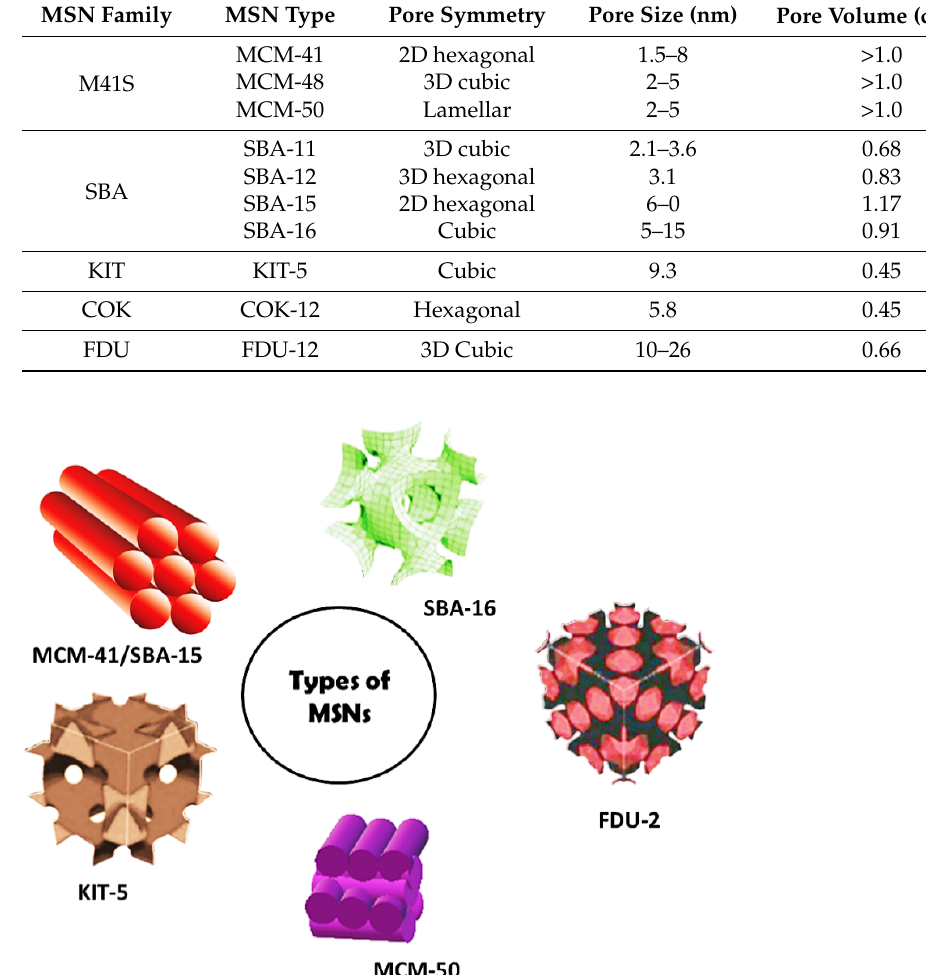
Figure 1. Different types of mesoporous silica nanoparticles. Reproduced with permission from the authors of [27]. Table 1. List of different types of mesoporous silica nanoparticles (MSNs) and their characteristic properties [27]. MSN Family